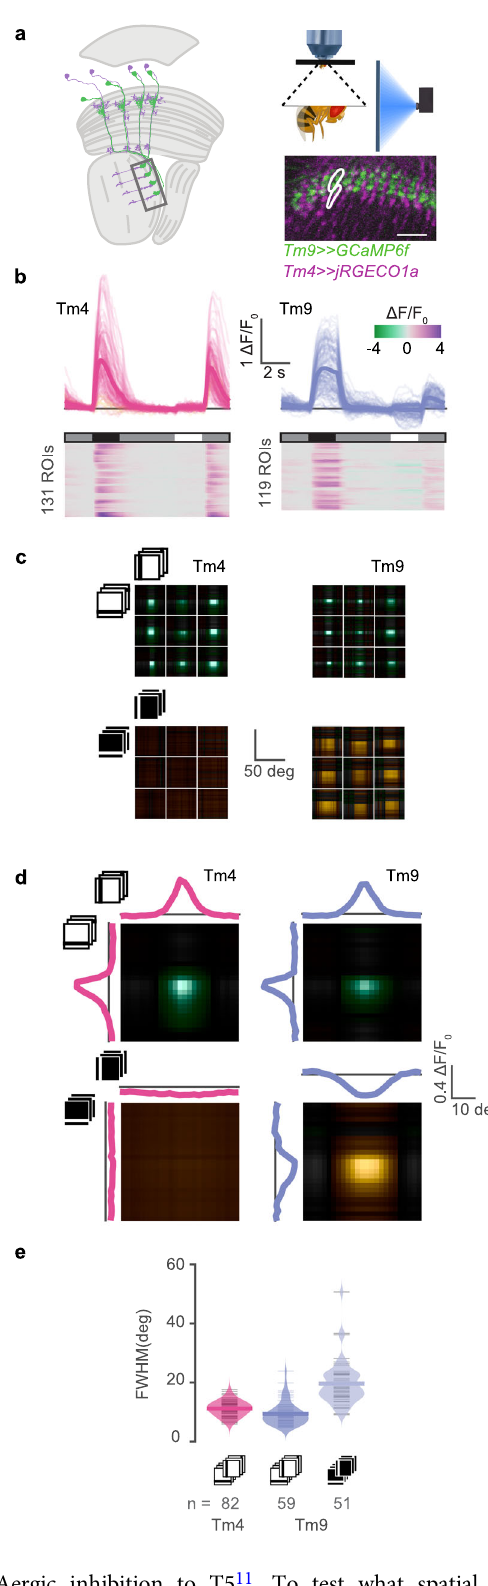
Fig. 3 Dual-color imaging reveals speci fi city of the Tm9 ON receptive fi eld. a Experimental setup used for in vivo two-photon calcium imaging under visual stimulation of Tm9 neurons expressing GCaMP6f (green), and Tm4 neurons expressing jRGECO1a (magenta). Scale bar = 10 μ m. b Responses to full- fi eld ON and OFF fl ashes from an intermediate gray background. Both Tm9 (blue) and Tm4 (pink) respond preferentially to OFF transitions, but only Tm9 responds (negatively) to ON fl ashes. Thick lines are means across ROIs, thin lines are single ROIs. c Receptive fi elds of nine example neurons from each neuron type. Only Tm9 has ON receptive fi elds. d Population average of receptive fi elds simultaneously recorded and aligned to the center for visualization by maximizing their cross-correlation. Both Tm9 and Tm4 have narrow OFF receptive fi elds but only Tm9 has a wide ON receptive fi eld. e Full width at half maximum (FWHM) obtained from fi tting a single Gaussian to each neuron ’ s receptive fi eld in the population. Tm9 ON (light blue, n = 51 ROIs), Tm9 OFF (blue, n = 59 ROIs), and Tm4 OFF (pink, n = 82 ROIs). ROIs come from 11 fl ies. Tm4 did not have an ON receptive fi eld. Values are averages over the two orientations. Only neurons with OFF receptive fi eld fi ts with r 2 > 0.8 for both orientations were included. Source data are provided as a Source Data fi